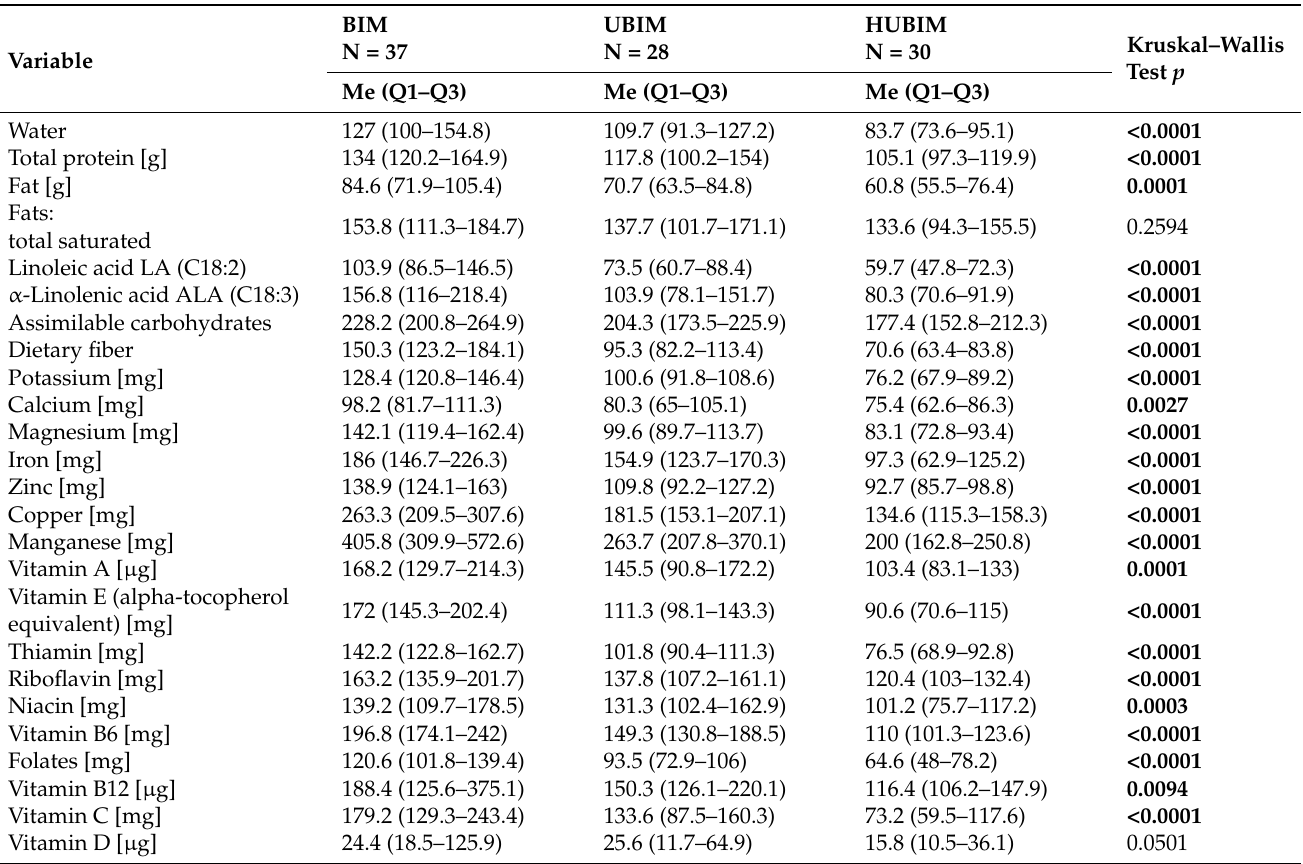
Table 3. Percentage of achieving dietary intake standards for macronutrients, individual vitamins, and minerals from consumed food and